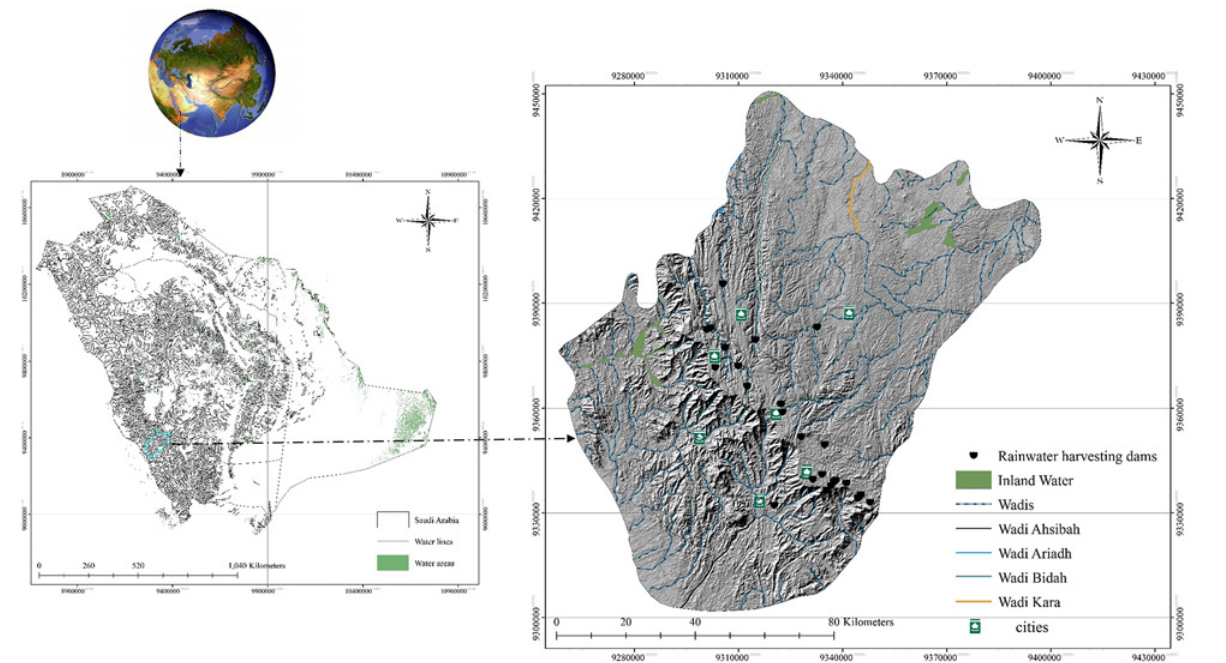
Fig 1. Location map of study